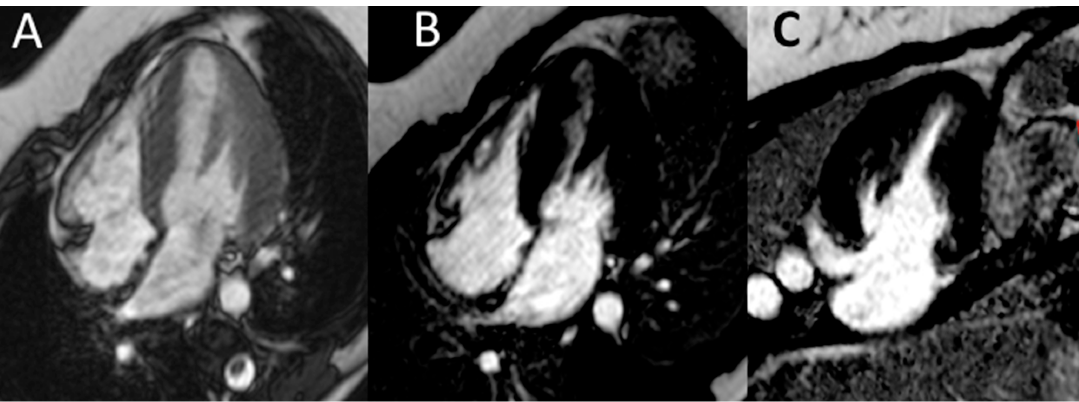
Figure 4. Cardiac magnetic resonance. Cardiac magnetic resonance (CMR) confirmed normal LV volume, systolic function and a moderate increase in LV thickness (panel A ). No abnormalities in late gadolinium enhancement in the horizontal long-axis view ( B ) or vertical long-axis view ( C ) were found.